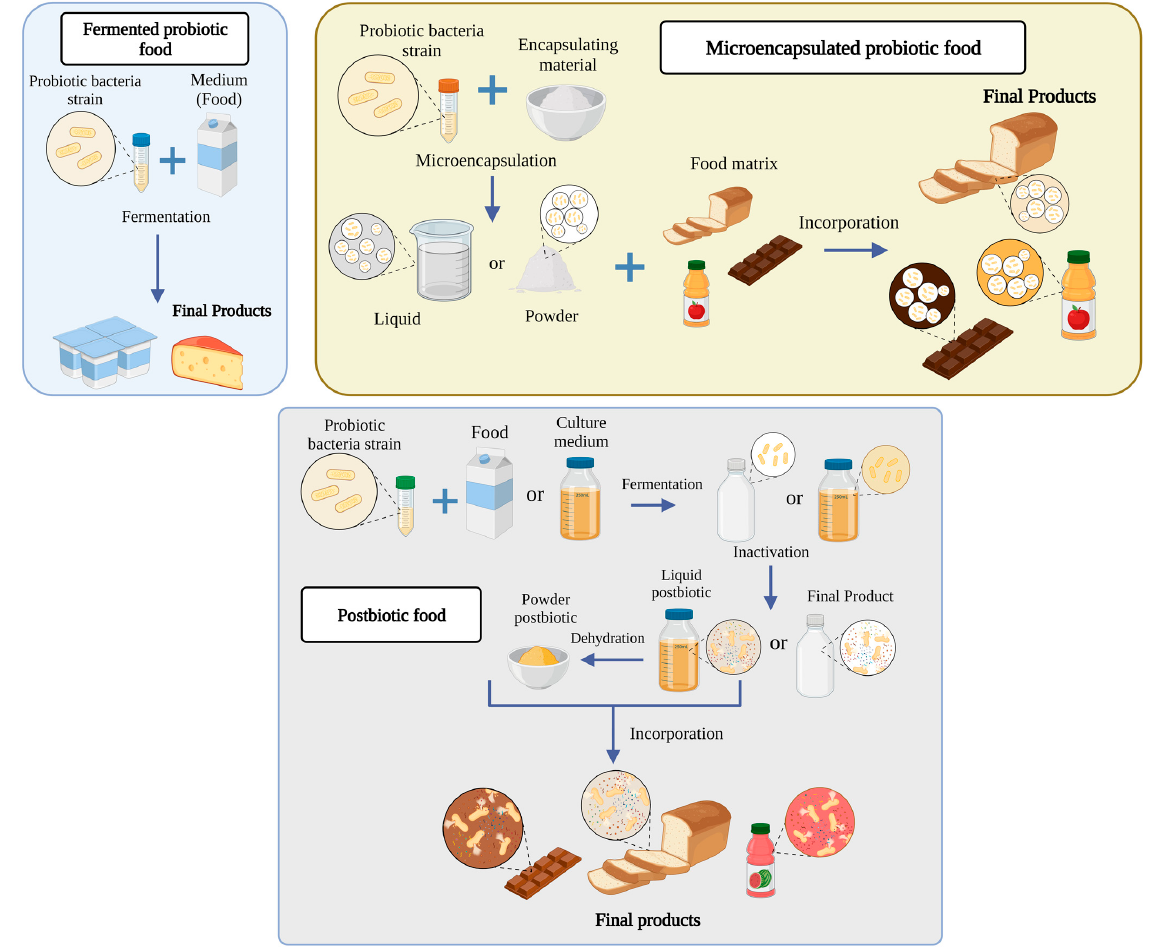
Figure 2. Types of food with probiotic